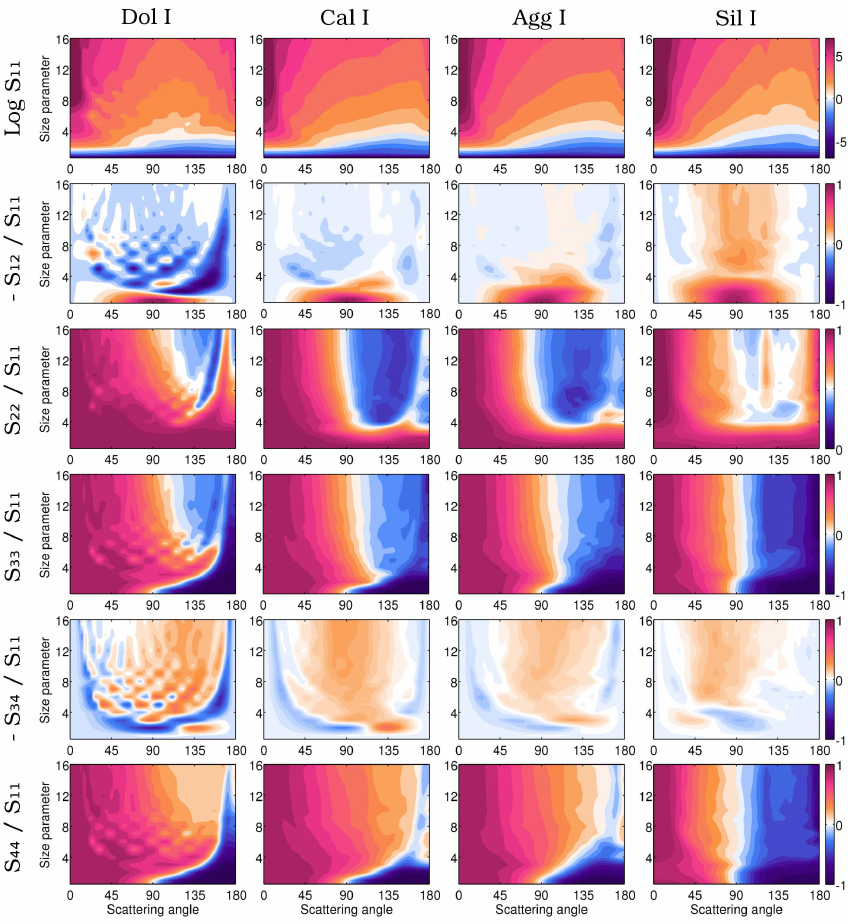
Fig. 7. Size and angular dependence of scattering by Dol I, Cal I, Agg I, and Sil I particles. The colour scales are presented on the right, separately for each matrix